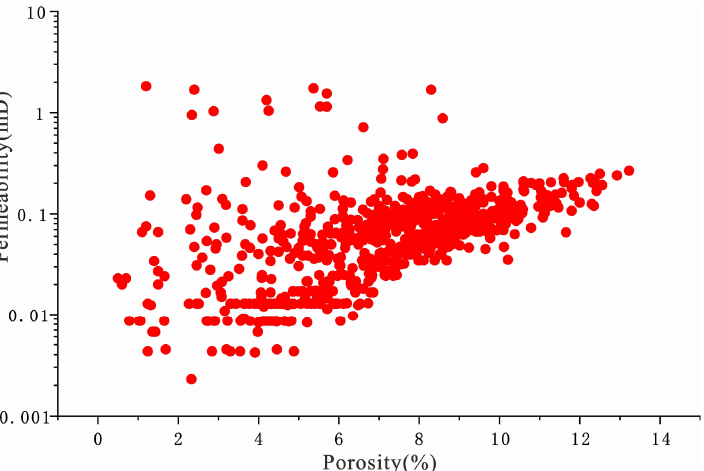
Figure 3. Core porosity vs. core permeability cross-plots for the Chang-7 Member sandstones in the Ordos Basin.